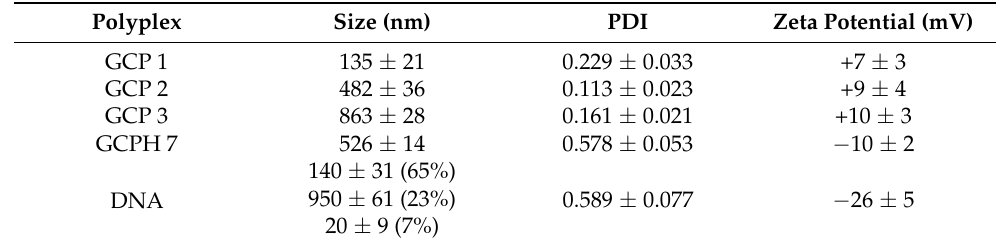
Figure 2. Representative intensity size plots of naked β-Gal DNA ( a ), GCP (GCP 1 contains 6 µg mL −1 β-Gal DNA, GCP 2 contains 84 µg mL −1 β-Gal DNA, GCP 3 contains 250 µg mL −1 β-Gal DNA, all GC, DNA ratios are 60, 1 g g -1 ( b ), GCPH 7 (84 µg mL −1 β-Gal DNA), with 7.2 mg mL −1 of hyaluronidase size distribution by intensity ( c ) and volume ( d ) at 24 and 48 h. Table 1. Size, PDI and zeta potential of GCP, GCPH and DNA. The data is representative of three independent measurements (= 3, mean ± SD).